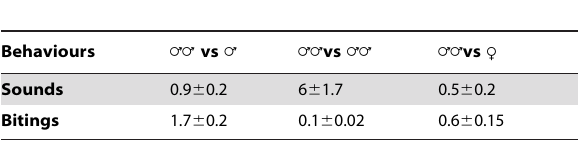
Table 5. Mean rate ( 6 SE) per minute of event-behaviour during confrontation of territorial males against intruders ( == vs. = , N =7, n =28), between territorial males ( == vs. == , N=3, n =12) and territorial males against females ( == vs. R , N=6, n =24).